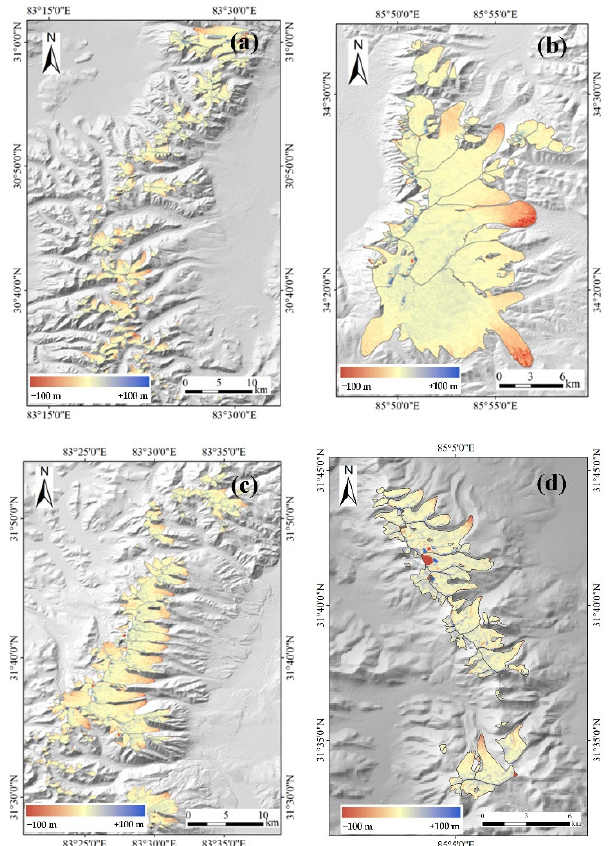
Figure 4. Same as Figure 3 but for the study sites of Gangdisi Mts. ( a ), Zangsigangri Mount ( b ), Unnamed-4 Mts. ( c ) and Unnamed-5 Mts. ( d ).